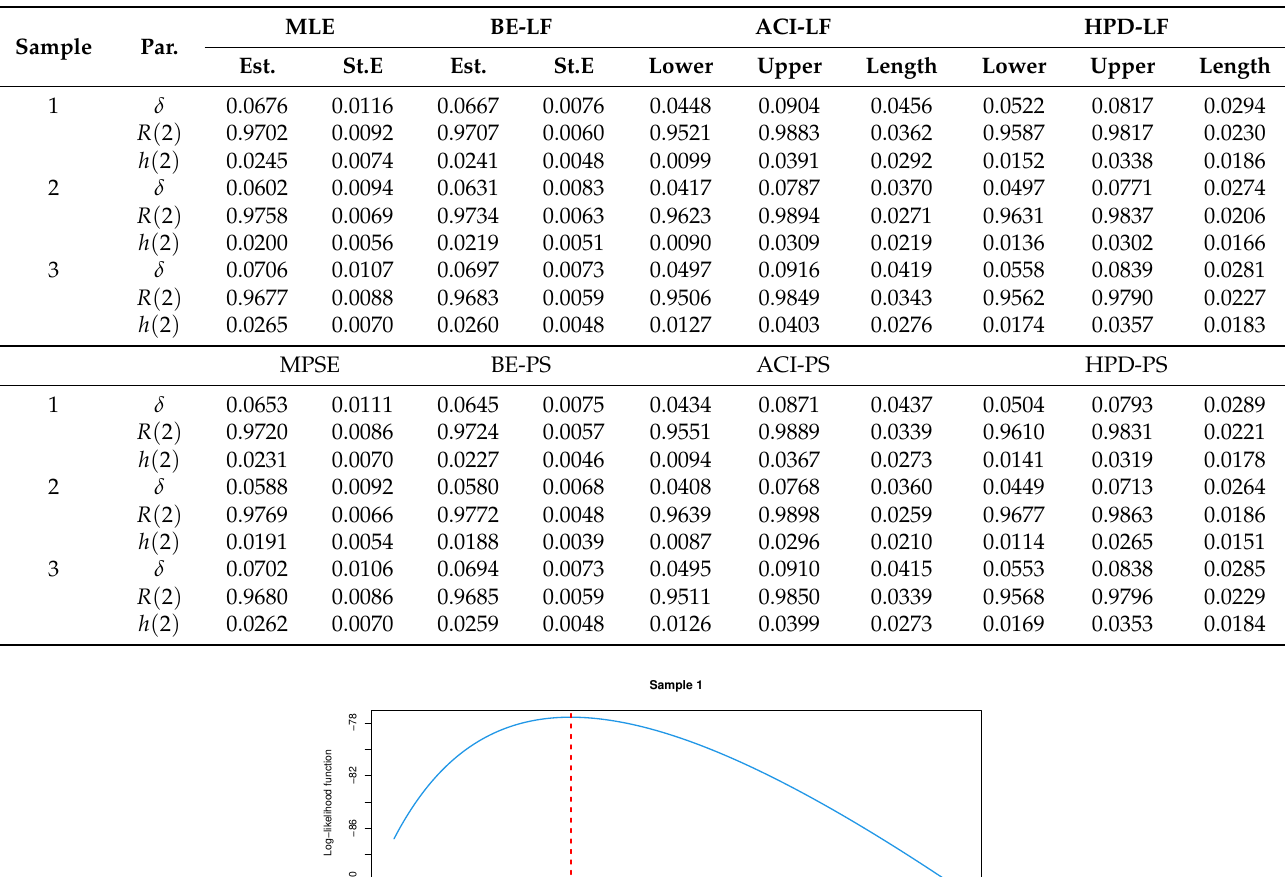
Table 9. Point and interval estimates of δ , R ( t ) and h ( t ) from MVAD data.